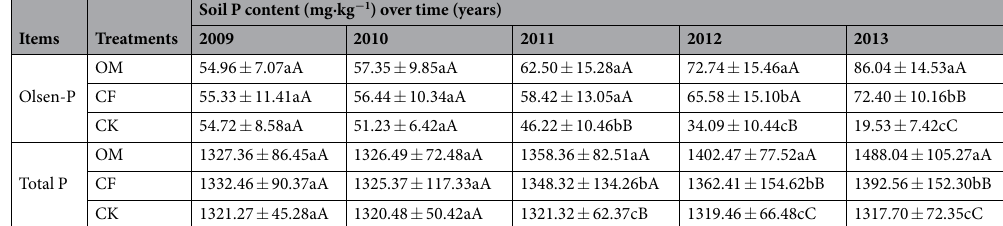
Table 2. Change in total P and Olsen-P affected by different fertilization modes in the surface soil layer (0–20 cm) over time. Note: The different lowercase and uppercase letters in the same column for each parameter indicate a significant difference at the 0.05 and 0.01 levels, respectively.